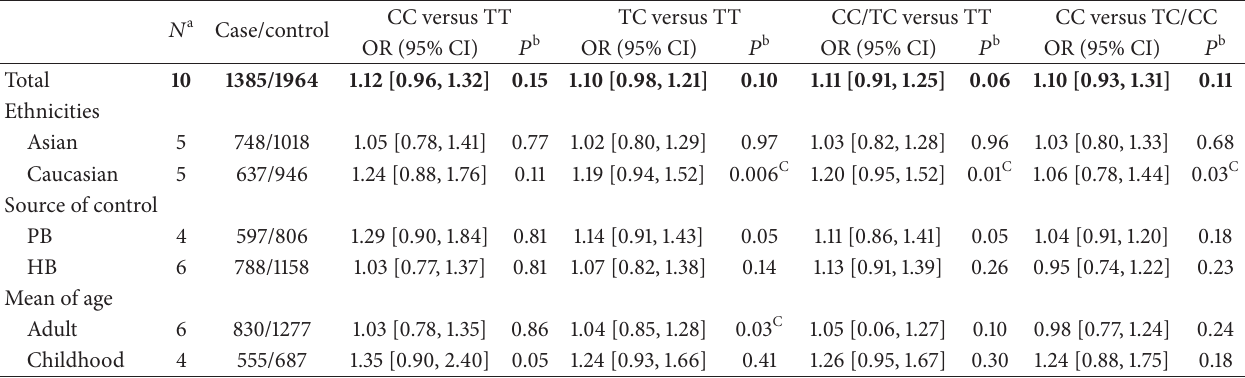
Table 3: Stratified analyses of the IL-1 𝛽 -511C/T polymorphism on asthma risk in meta-analysis.